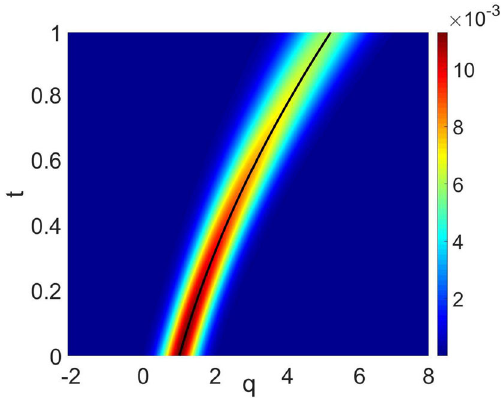
Fig. 27 Variations in the probability distribution of the scale factor. The horizontal and vertical axes represent the scale factor ( q ) and time variable, respectively. The black curve shows the evolution for the clas- sical trajectory of the universe. The parameters are taken as: α = 0 . 5, V 0 = 40, Q 0 = 1, (cid:18) =